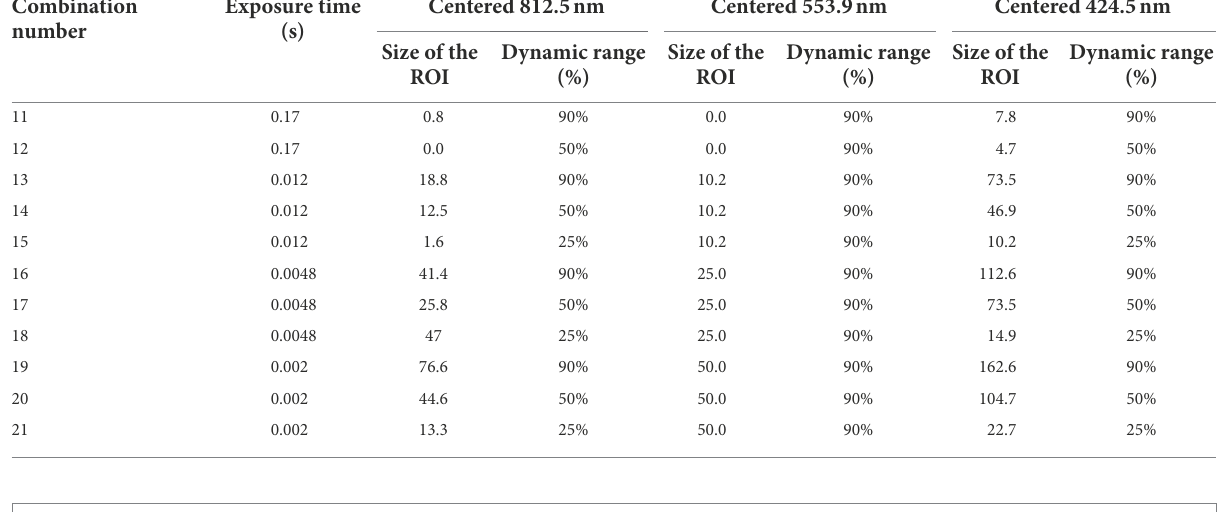
TABLE 2 Combinations of wavelength resolutions and exposure times for LDA and SVM classifier.